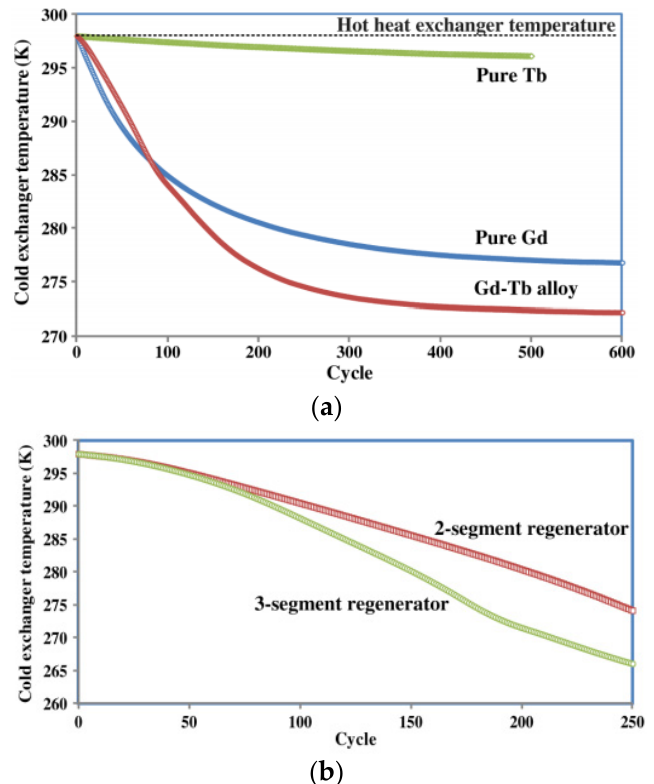
Figure 31. Temperature of the cold exchanger as a function of the cycles: ( a ) comparison of the MCM; ( b ) observation of the multi-segment performances [75].